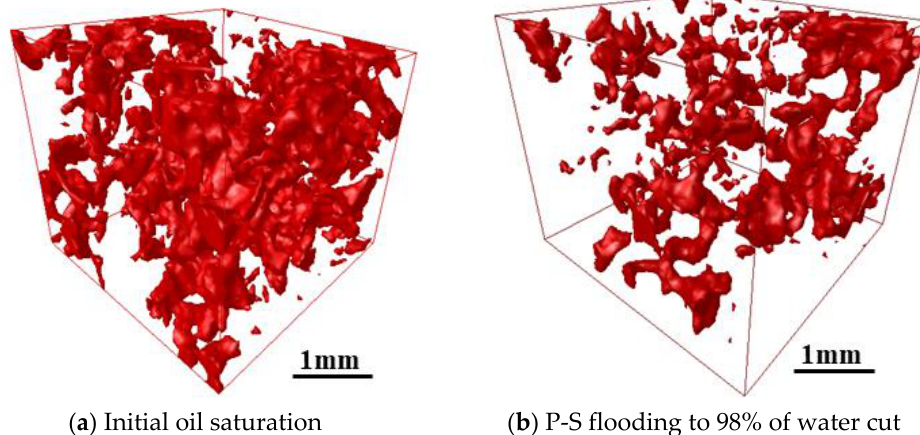
Figure 10. 3-D visualization of oil droplet after P-S flooding in the No. 1 rock sample.